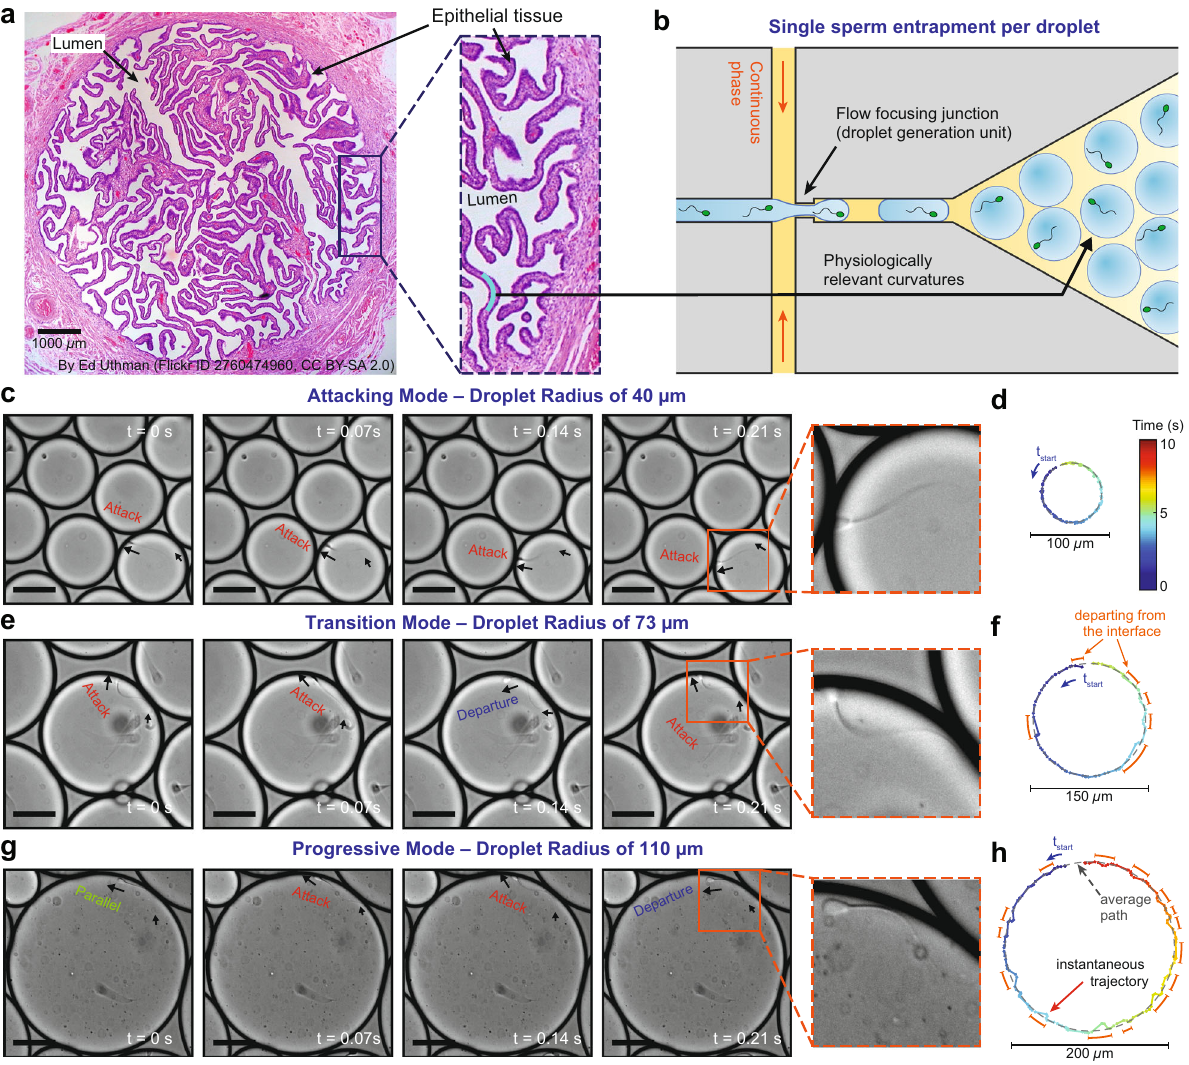
Fig. 1 Sperm motility at curved interfaces representing the soft and folded epithelial tissue in the female fallopian tube. a The female fallopian tube is a complex microenvironment composed of soft and highly folded epithelial tissue, forming con fi ned lumens with radius of curvatures ranging from ~20 μ m to over 150 μ m (refs. 3,5,18 ). b Encapsulation of individual sperm in monodisperse droplets ranging in size from 30 to 140 μ m, mimicking the physiologically relevant range of curvatures in vivo. Time-lapse images and representative trajectories of sperm swimming in ( c , d ) aggressive attacking, ( e , f ) transition and ( g , h ) progressive surfaces aligned motility modes in 40, 73, and 110 µ m-radius droplets, respectively. The color of the instantaneous swimming trajectories corresponds to time, as shown in the legend in ( d ). Orange dashed lines highlight the deviation between instantaneous trajectory and average path due to departing behavior. Scale bars, 50 µ m. Images were contrast-adjusted for clarity. The fallopian tube cross-section in ( a ), entitled “ Normal Fallopian Tube, Human ” , by Ed Uthman is sourced without change from https://www. fl ickr.com/photos/euthman/2760474960/ under CC BY 2.0. Each experiment was repeated 5, 4 and 5 times independently with similar results for ( c , e , and g ), respectively. Source data are provided as a Source Data fi